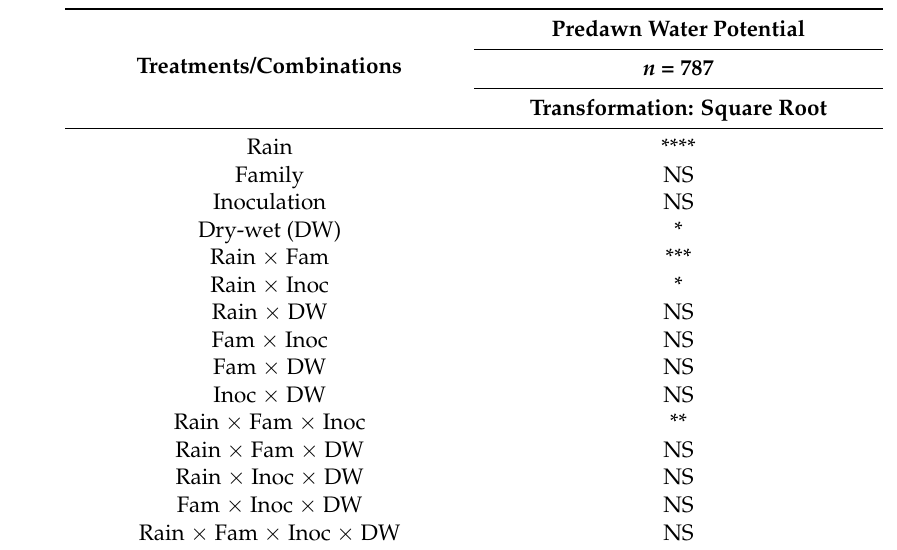
Table 3. Results of ANOVA F -tests for water potential